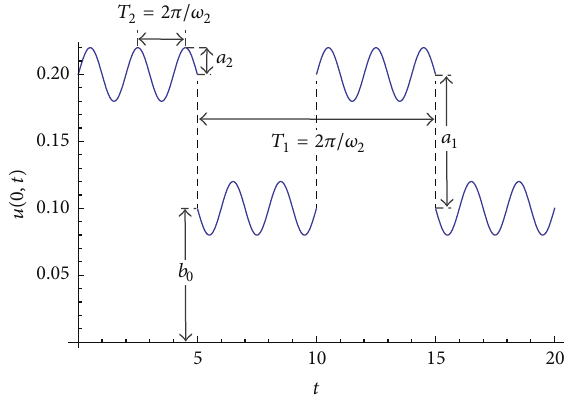
Figure 2: External material flow density